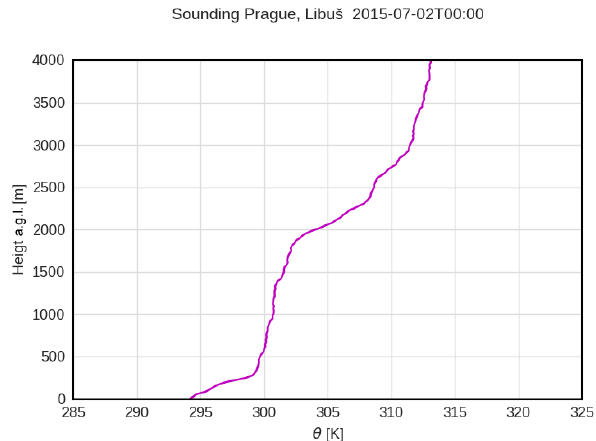
Figure 5. Initial vertical profile of potential temperature ( θ ) as used for initialization of